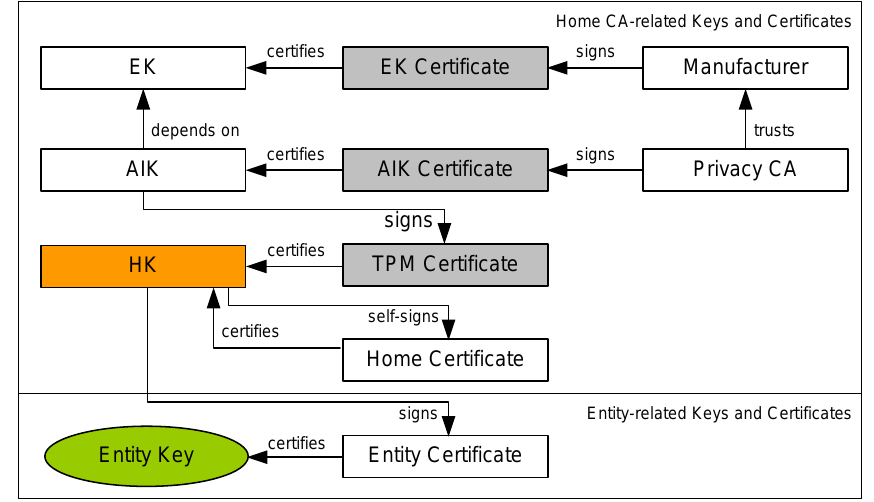
Figure 5. Changed key and certificate hierarchy inside the home network.